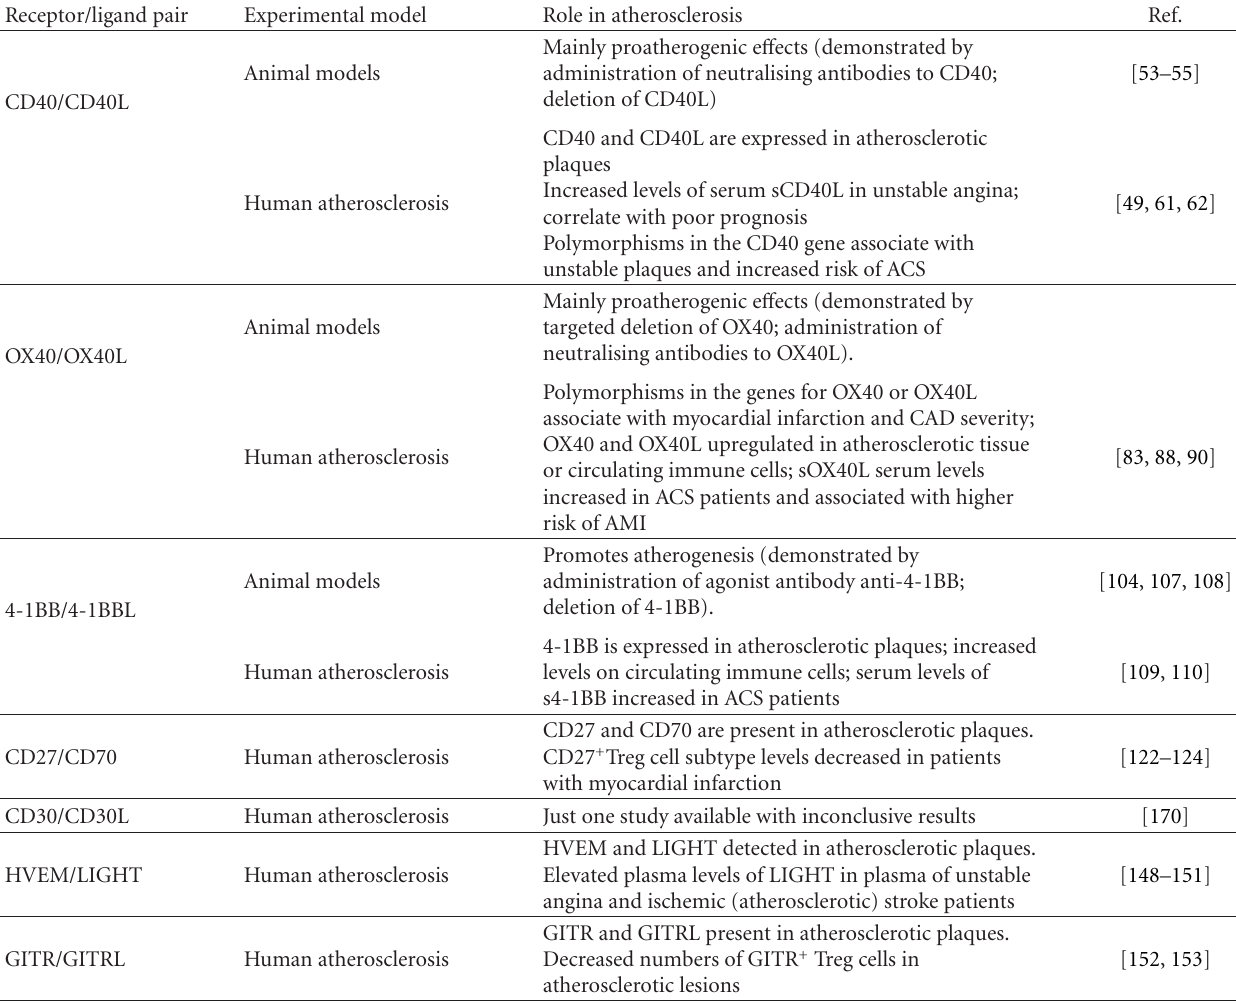
Table 2: TNF superfamily members and their role in